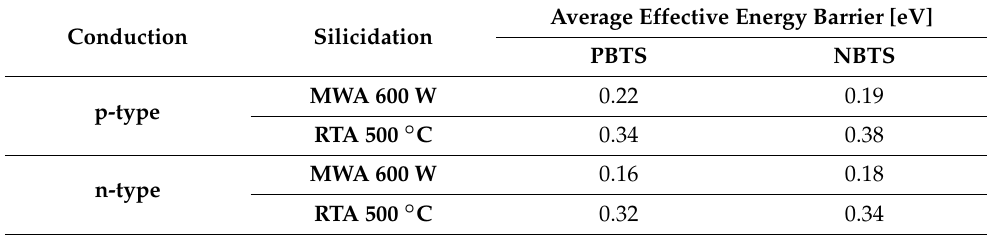
Table 4. The average effective energy barrier height ( E τ ) of the MWA- and RTA-NiSi x SB-TFTs obtained from the PBTS and NBTS tests.